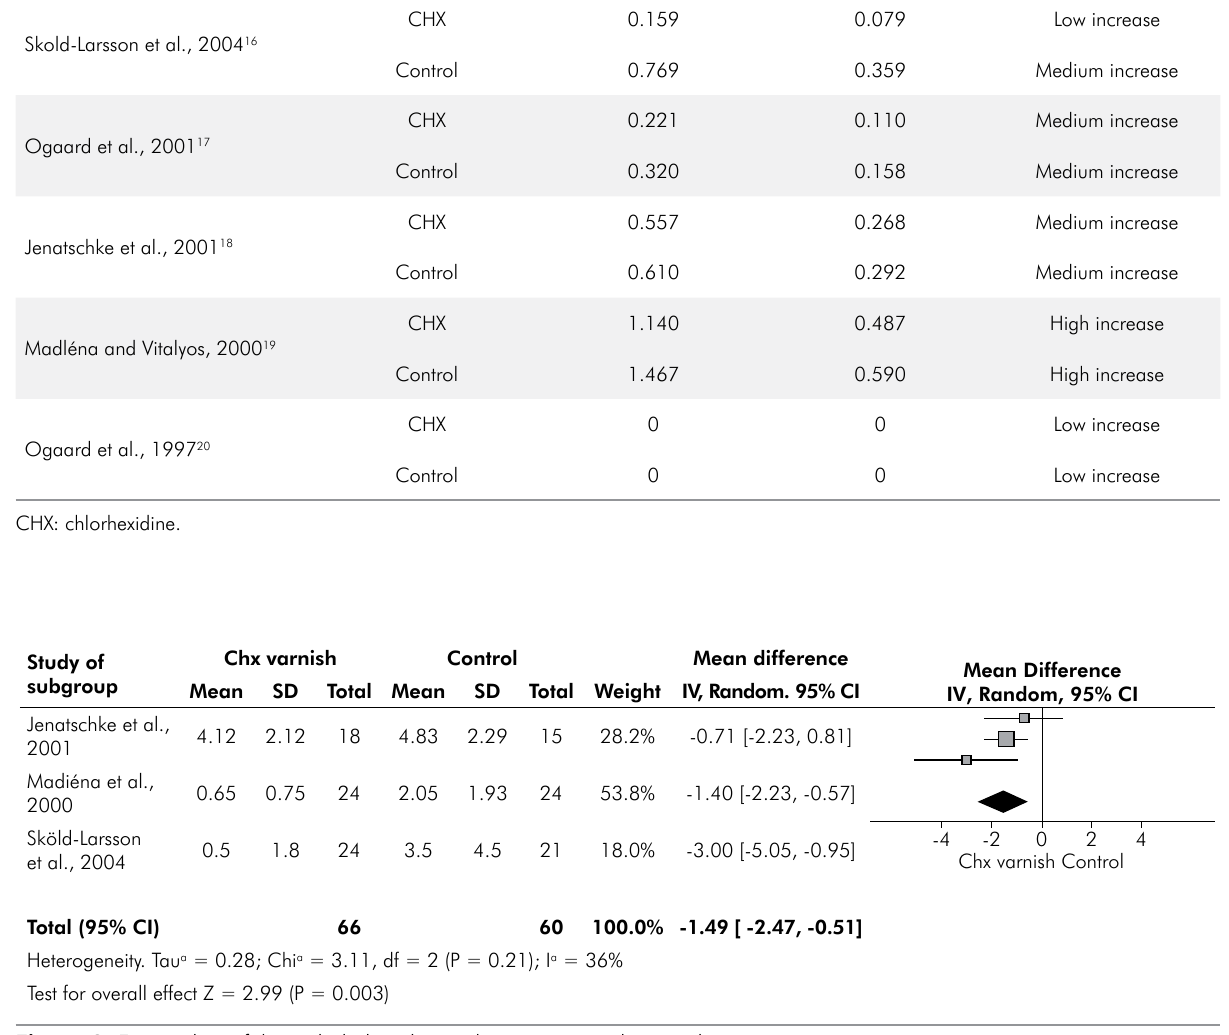
Figure 2. Forest plots of the included studies in the continuous data analysis.